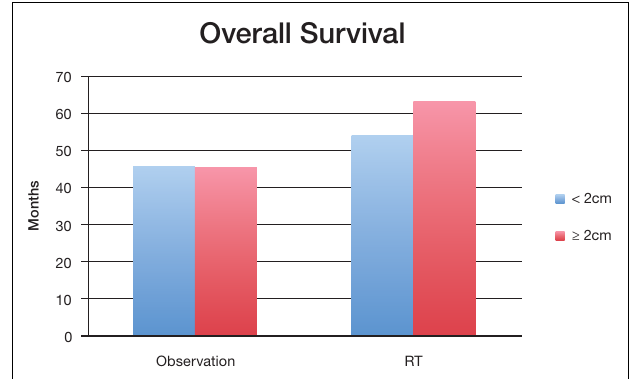
FIGURE 2 | Median overall survival of different size tumors between observation and postoperative radiation therapy cohort .